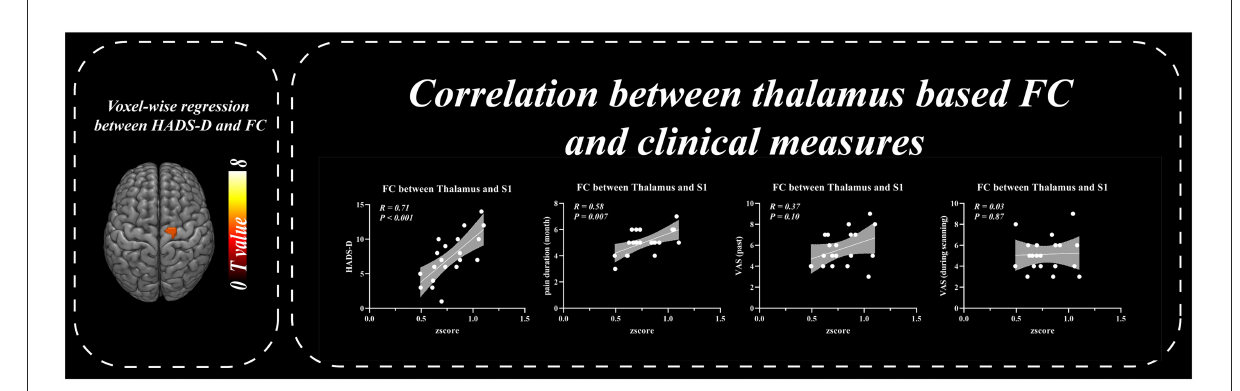
FIGURE4 Correlation between thalamus based functional connectivity and clinical measures. Resting-state functional connectivity between thalamus and SI was positively correlated with HADS-D and pain duration in BC patients.